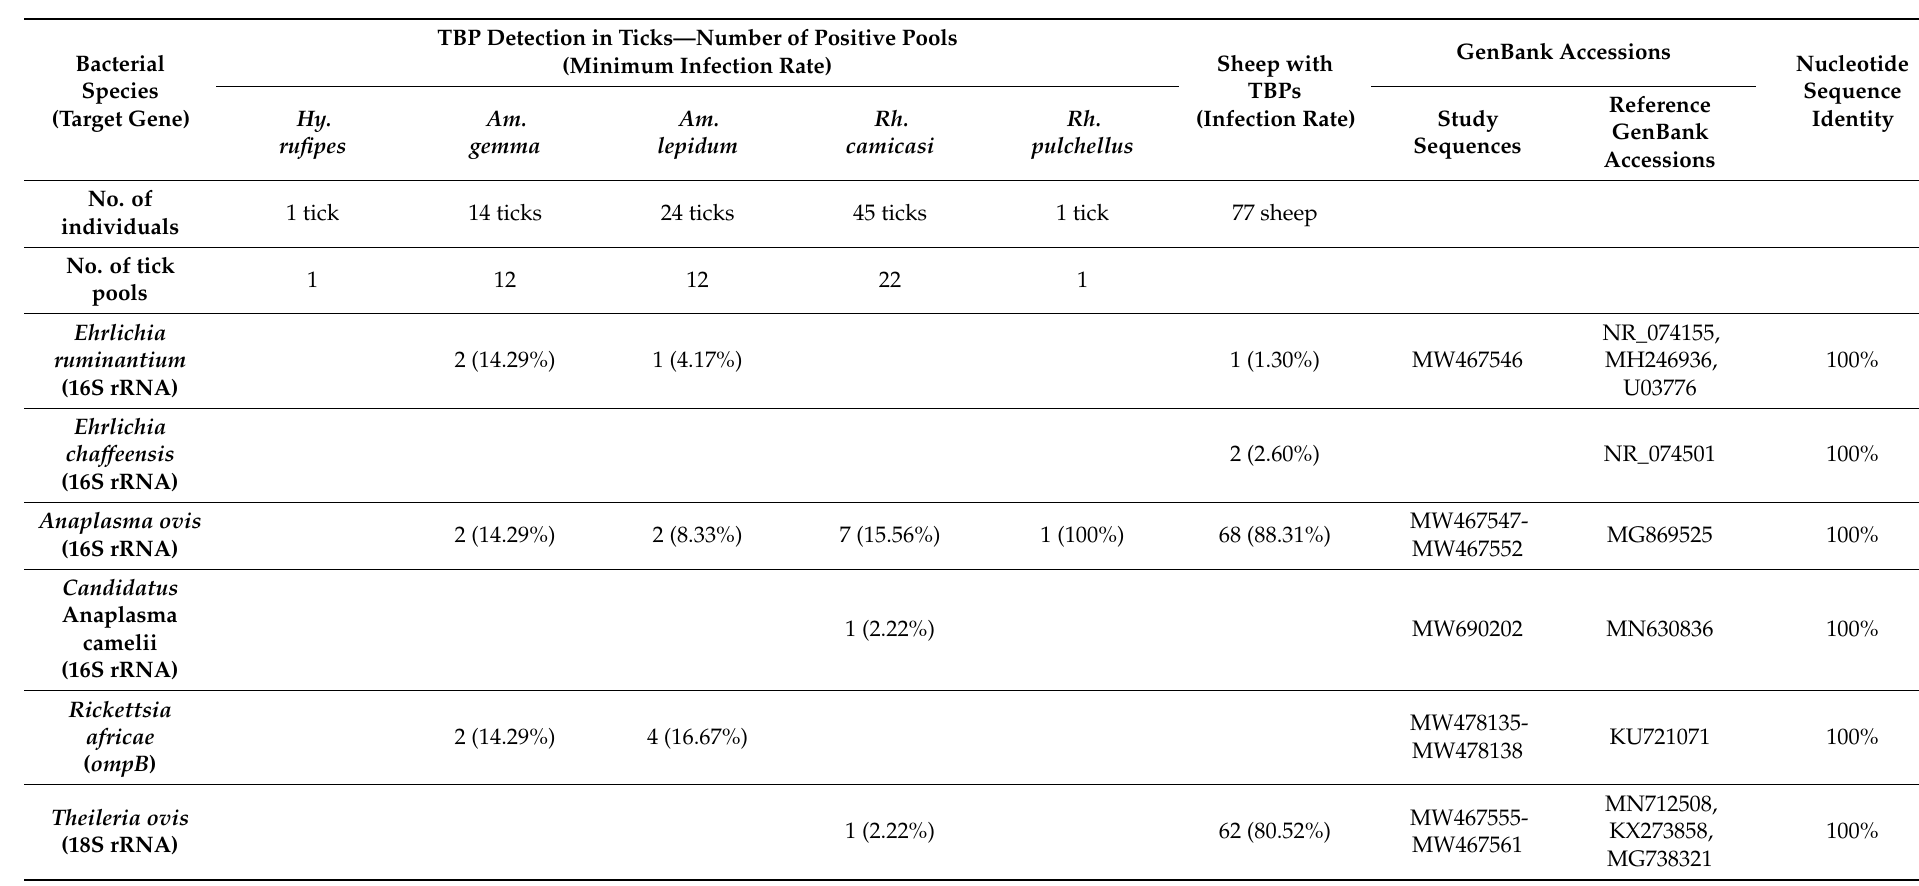
Nucleotide Sequence Identity Hy.